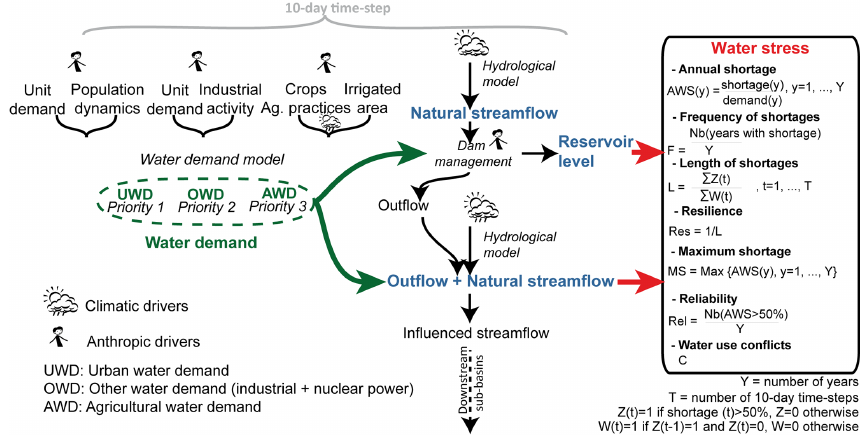
Figure 2. General framework for the integrative modeling chain developed and applied to the Hérault and the Ebro basins at a 10-day time step over the 1971–2009 period. Water demand and natural streamflow were simulated based on climatic and anthropogenic drivers. Anthropogenic influence on streamflow was assessed through the simulation of demand-driven dam management and consumptive use. Water stress was assessed by comparing demand to availability and characterized through the use of